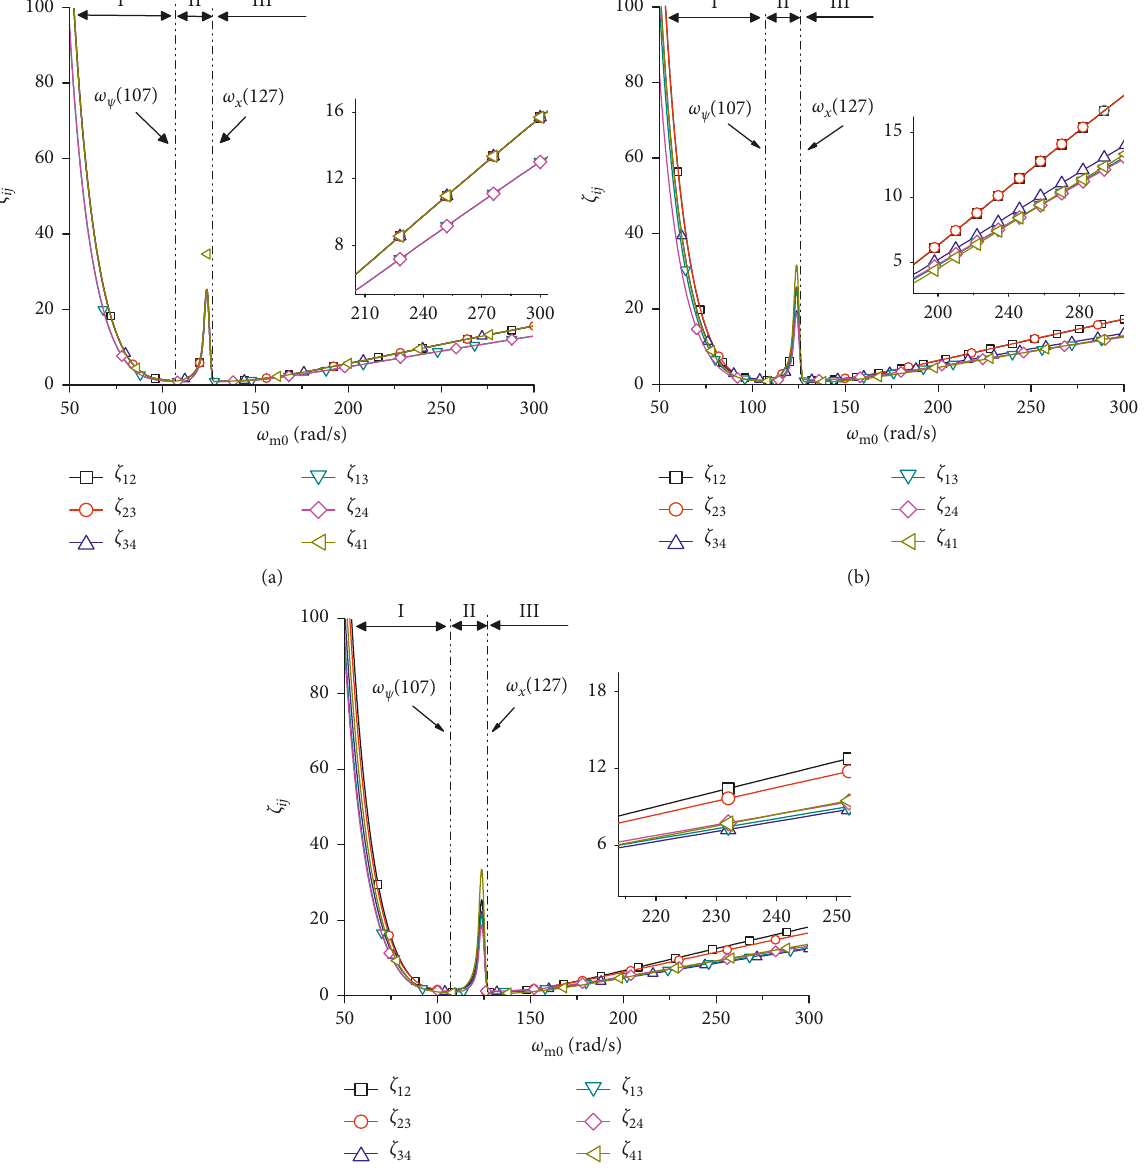
i 1 , 2 , 3 , 4 i ( (cid:31)